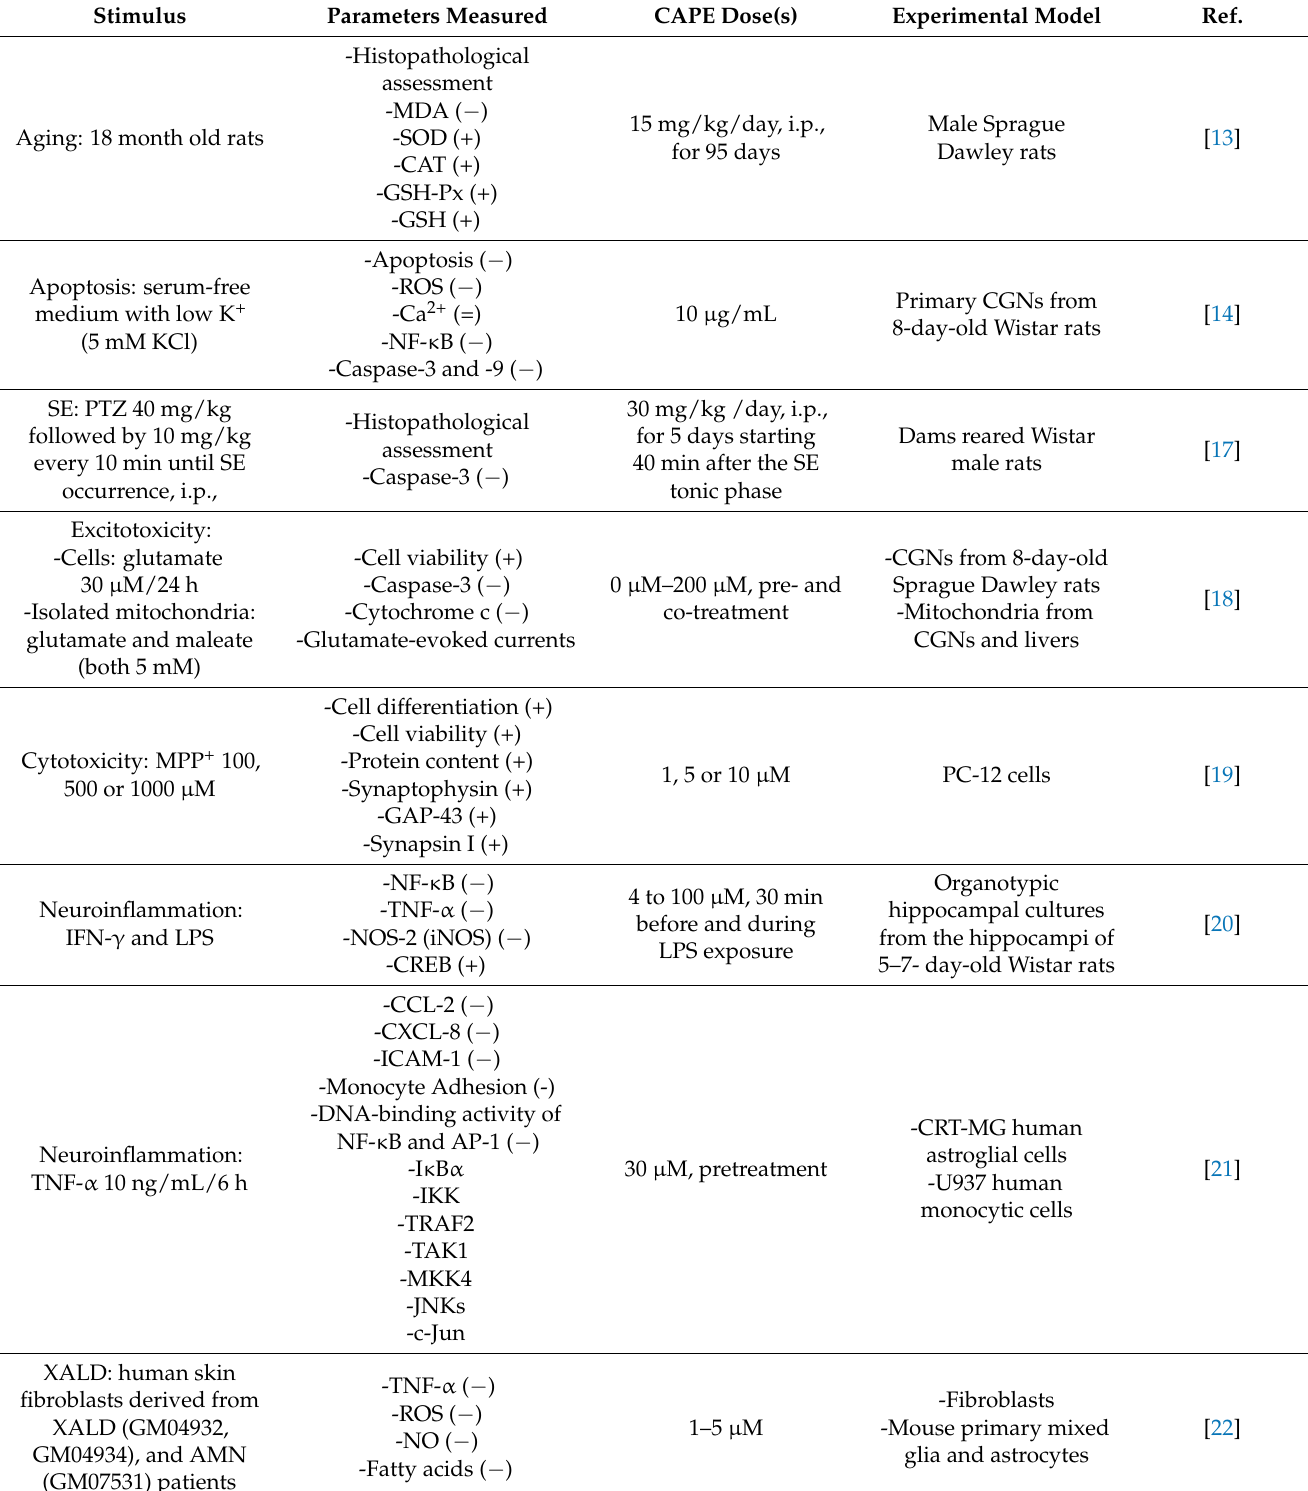
Table 1. CAPE protective effects in different neurological disorders. Where applicable, the effect of CAPE on the parameters measured is reported between parentheses (+, − or